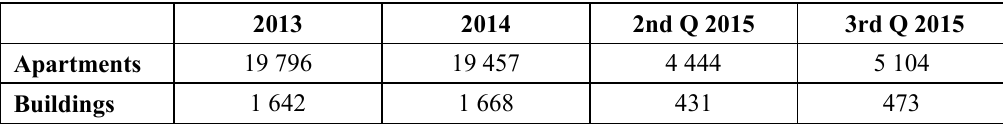
Table 3 . The Number of Real Estate Transactions in Latvia (State Land Service of Latvia, 2015) *